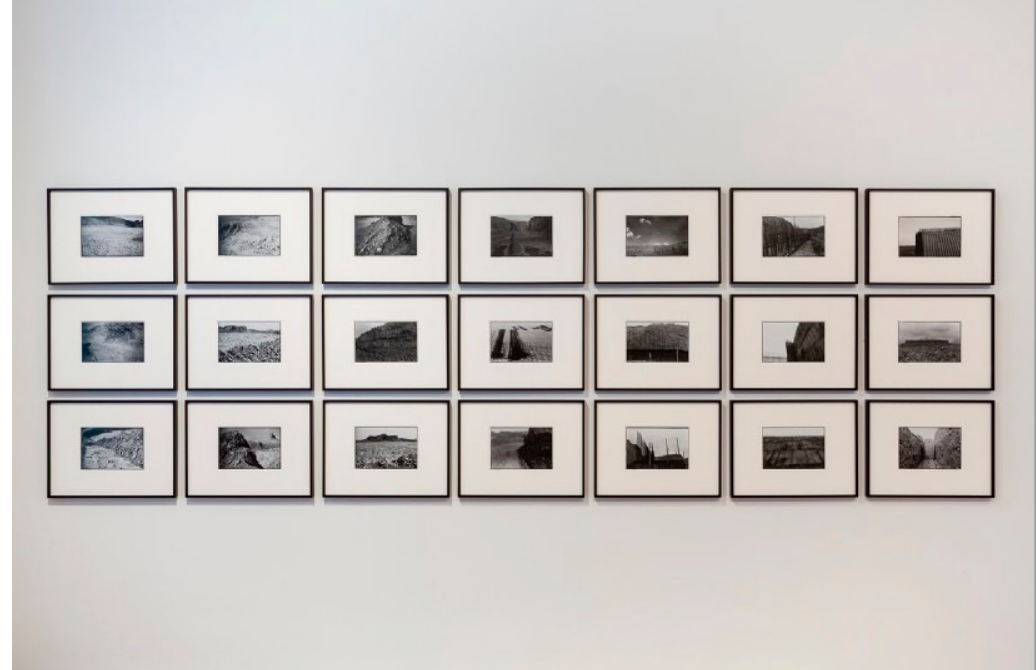
Figure 8. Mohammad Ghazali, from the Persepolis 2560–2580 series, installation view, Ab-anbar Gallery, London 2021.